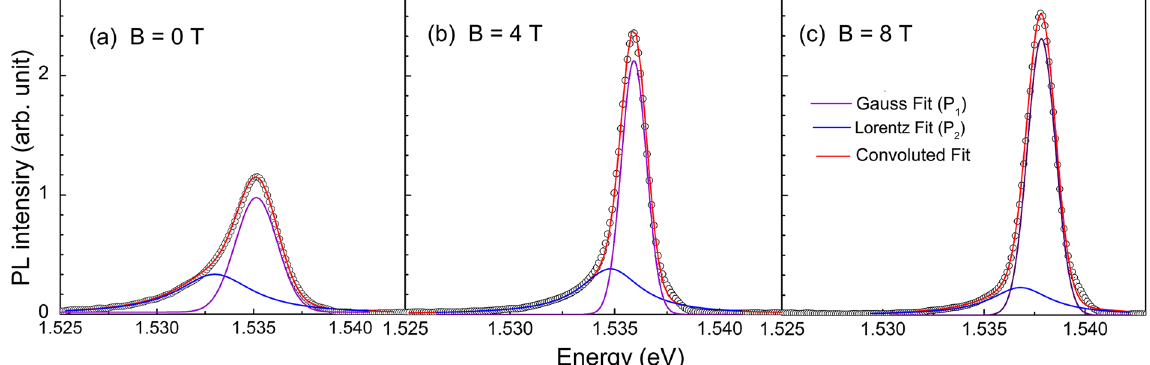
Figure 2. 4.2 K PL spectra (open circles) of 190 Å thick QW (QW-1) in MQW sample at ( a ) 0, ( b ) 4 and ( c ) 8 T magnetic field. PL spectra is deconvoluted by Gaussian components P 1 (purple curve) and Lorentz component P 2 (blue curve) to fit the asymmetric PL line shape (red curve).